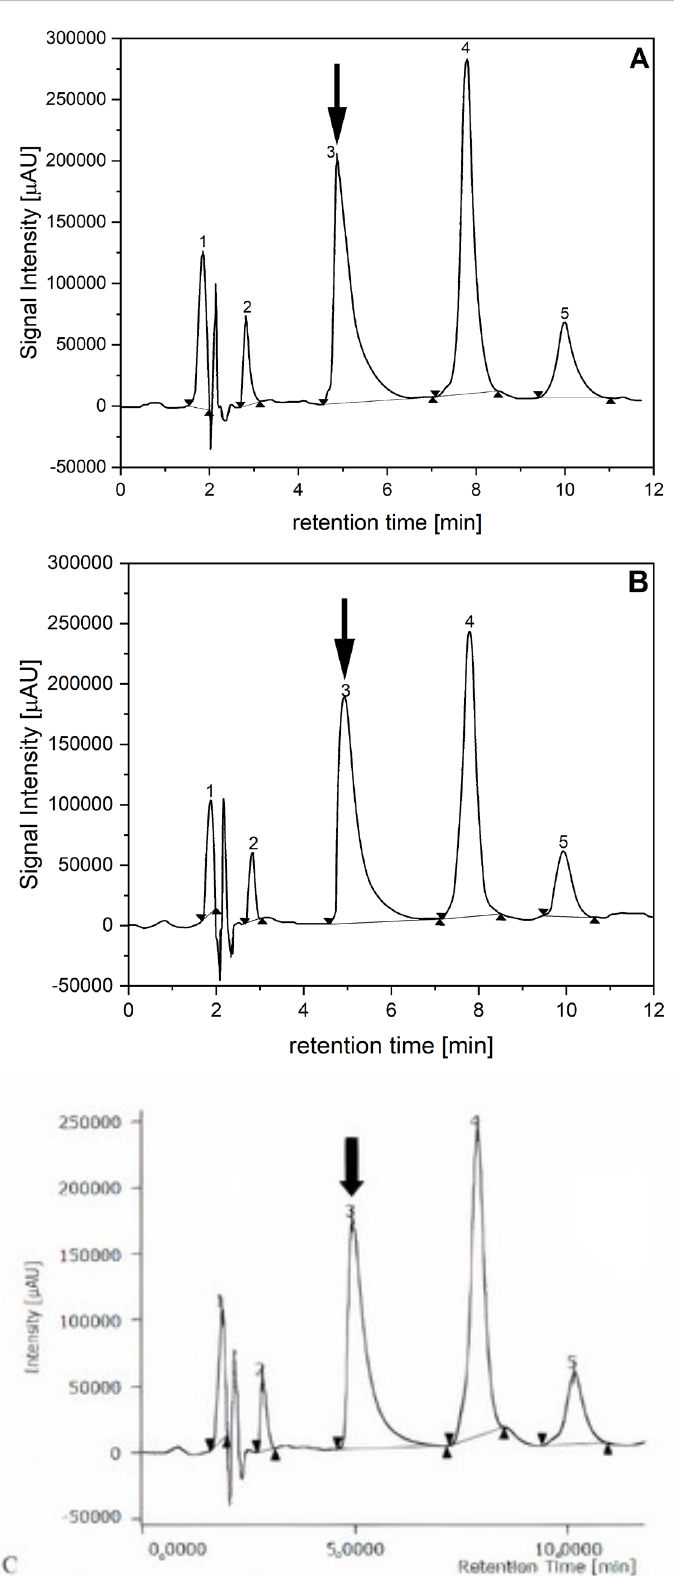
FIGURE 4 - Chromatograms from the extended stability study in A. infusion bag; B. peridural infusion administration sets and C. syringes. 1. Compound of fentanyl ampoule; 2. CLO HCl; 3. Suspect peak 2; 4. ROP HCl and 5. FENT CIT. In detail (black arrow) to identify the suspect